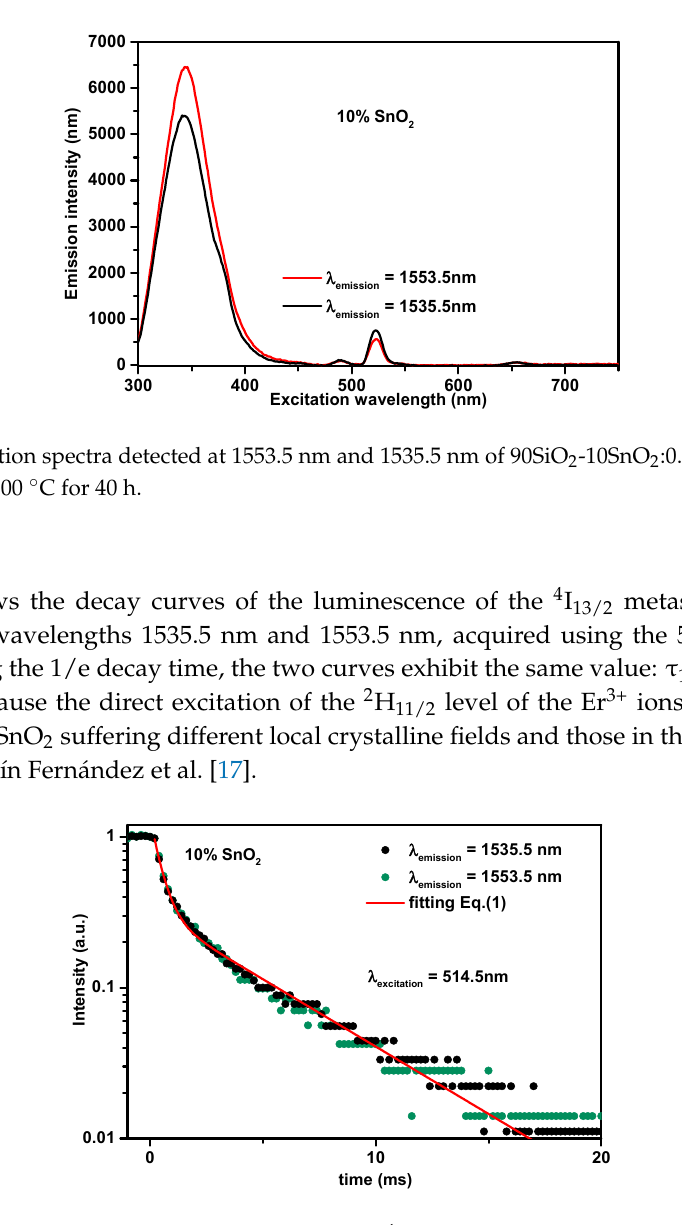
Figure 4. Emission spectrum of 90SiO 2 -10SnO 2 :0.5Er 3+ monolith heat-treated at 900 °C for 40 h excited at 514.5 nm by using an Ar + laser as an excitation source.